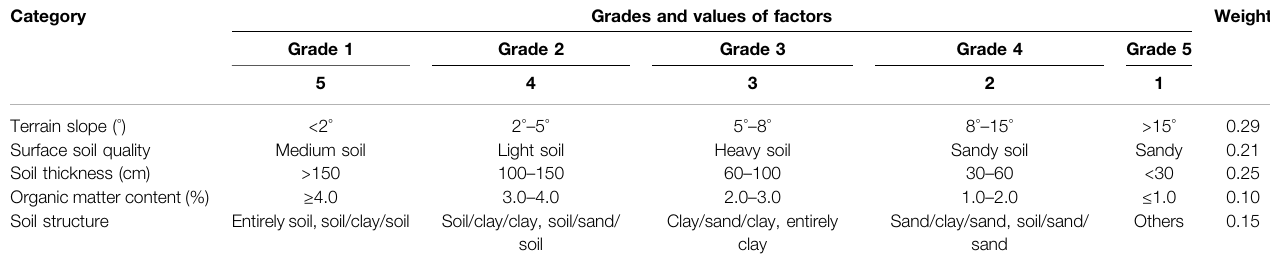
TABLE 1 | Evaluation indicators of natural suitability of farmland.